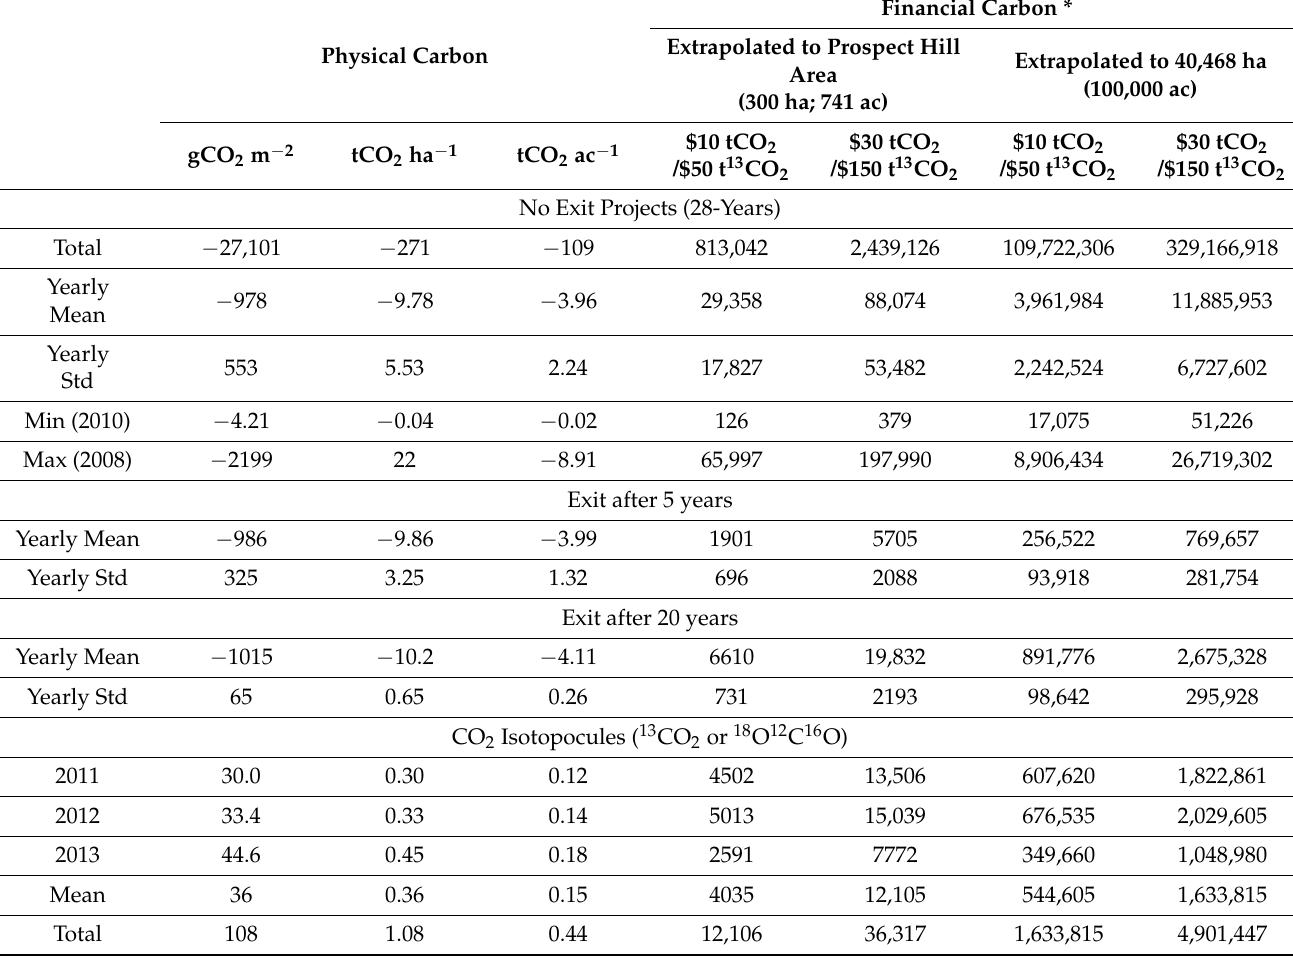
Figure A3. R eco vs. GPP for yearly sums (small light blue points), monthly sums multiplied by 12 (small orange points), monthly sums averaged by the month of the year and multiplied by 12 (big points), and the identity line (green dashed line). Table A1. Harvard Forest Annual Statistics.